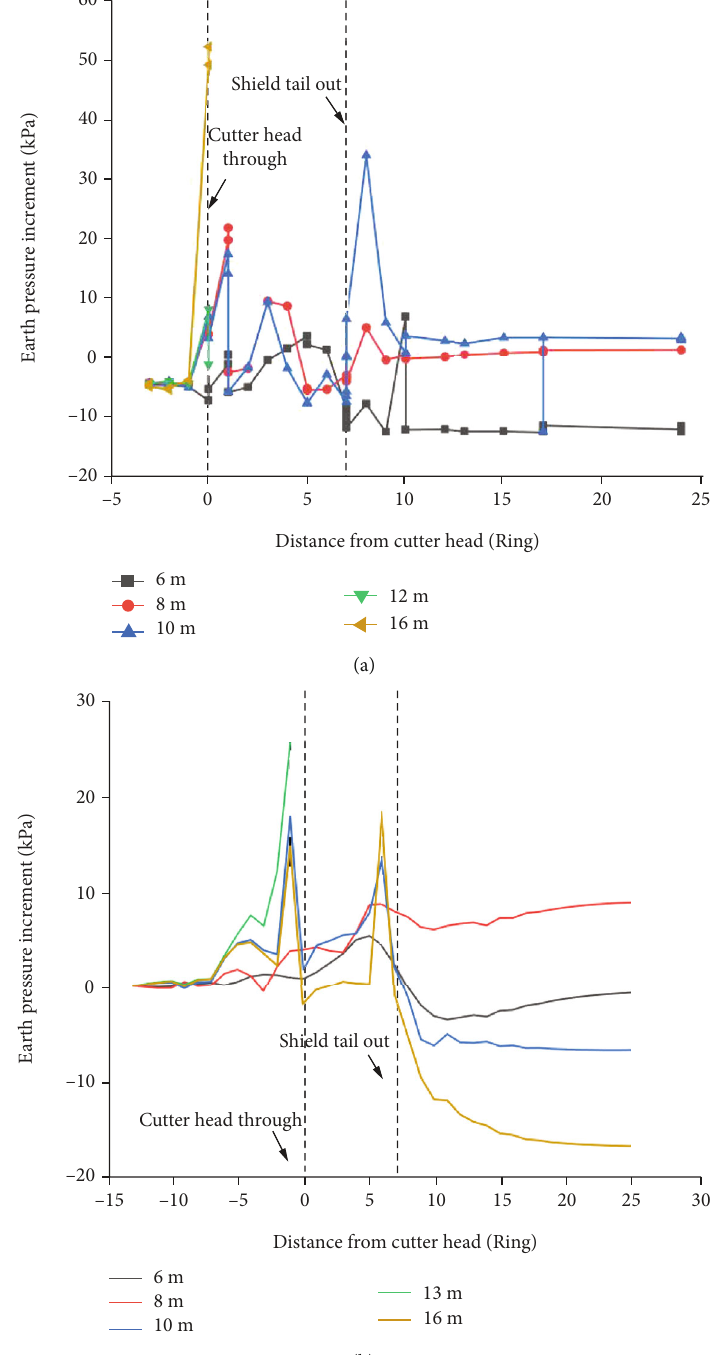
Figure 10: Earth pressure increment time history curve at di ff erent depths of tunnel centerline: (a) measured values and (b) calculation